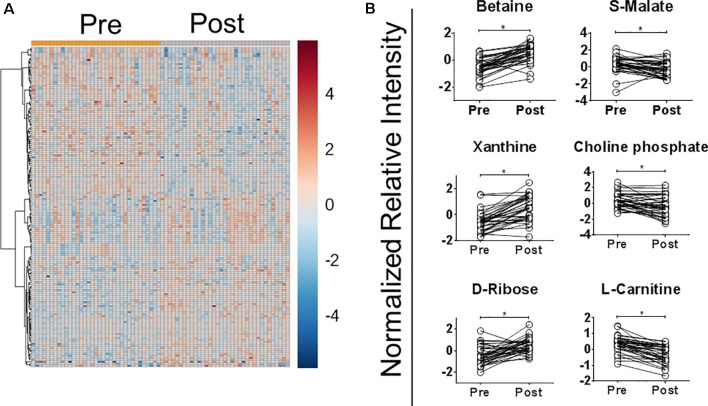
Exposure to meglumine antimoniate alters the plasma metabolome of CL patients. Plasma samples from CL patients (n = 35) obtained before (Pre) and at the end of treatment (Post) with MA were analyzed by LC/MS. (A) Heatmap representation of the normalized relative intensity of metabolites with significantly different abundance between samples obtained before and at the end of treatment, built using Euclidean distance and ward clustering algorithm. (B) Paired dot plot of identified metabolites significantly modulated after treatment with MA. Data were normalized using the pooled sample from the pre-treatment group. Statistical significance in dot plots was determined using paired t-test. *p <0.0.